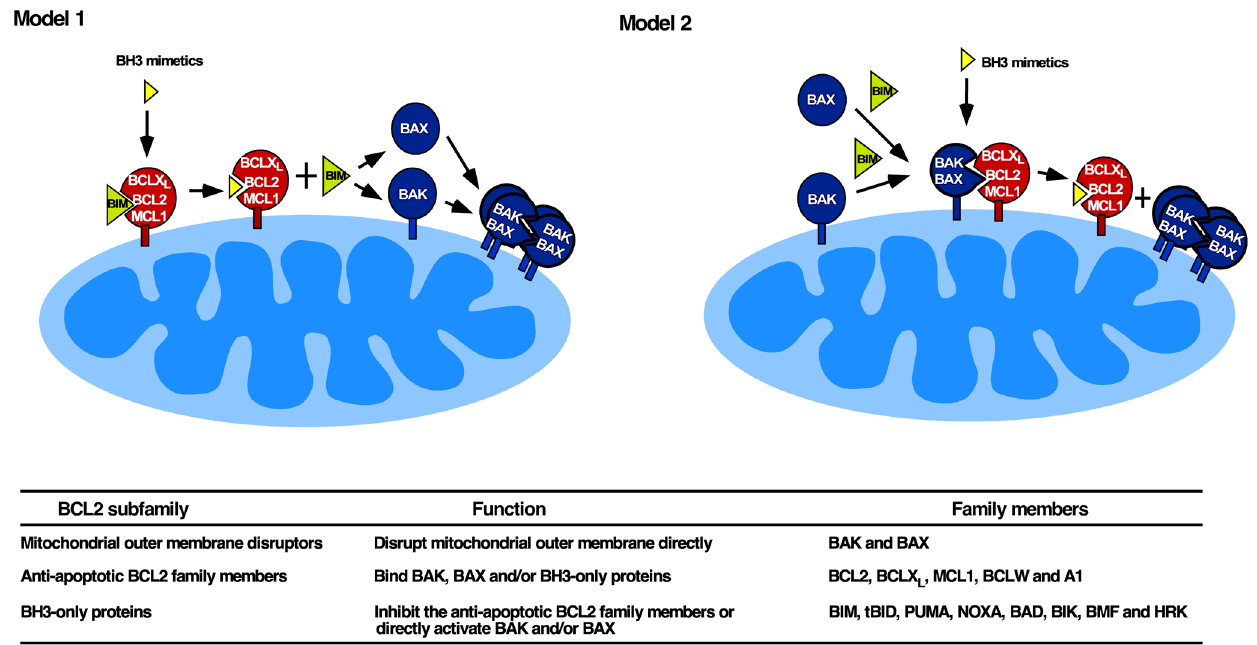
Figure 1. Two models of BH3 mimetic action. In Model 1 (left), BH3 mimetics are thought to displace activated BIM from anti-apoptotic BCL2 family members, allowing BIM to subsequently activate BAX and BAK 44 . In Model 2 (right), BAK and/or BAX are constitutively activated and are displaced from anti-apoptotic BCL2 family members by BH3 mimetics 46 . Model 2 is more compatible with recent studies showing that BAK and BAX can be activated in the absence of BH3-only proteins under cell-free conditions 46 and in gene-targeted HCT116 cells 123 . It is, however, possible that one mode of activation predominates in some cell lines or tissues and the other mode predominates in others. Table below figure, summary of BCL2 subfamilies, their functions, and